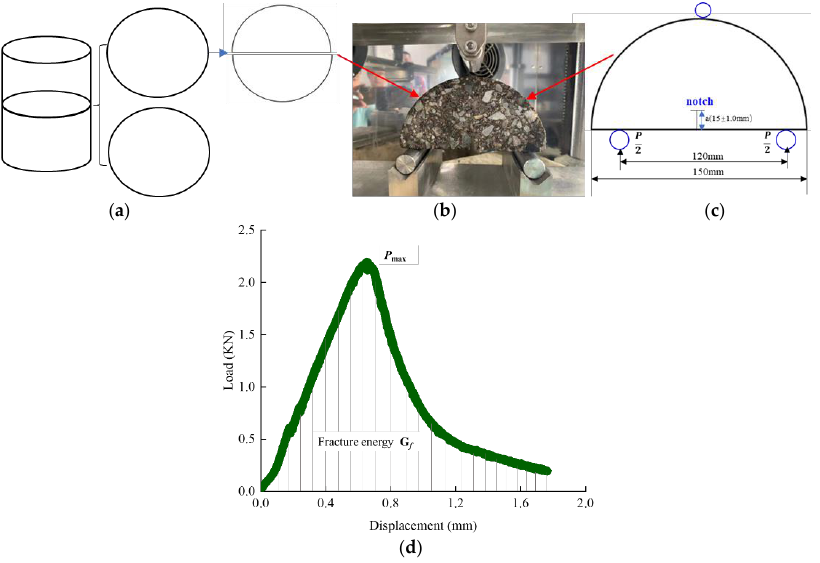
Figure 7. Semi-circular bending test schematic: ( a ) compacted specimens and test slices; ( b ) loading process; ( c ) key dimensions; ( d ) SCB loading curves and calculation diagram of fracture energy.